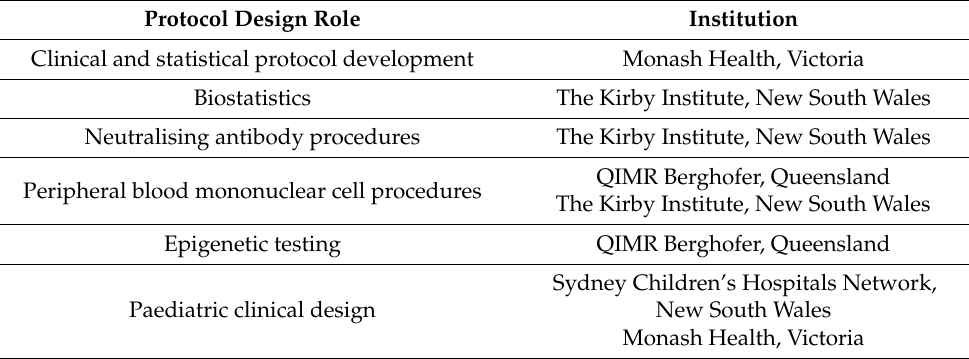
Table 1. Collaborating institutions and roles. Protocol Design Role